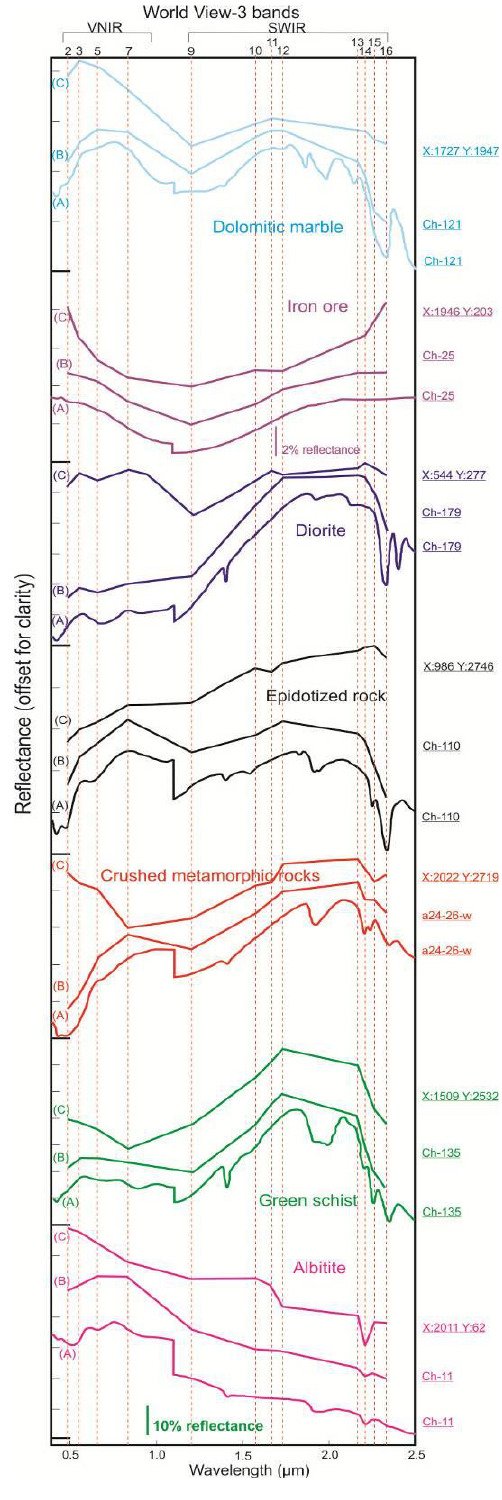
Fig. 8. VNIR-SWIR spectral triplet of (A) high resolution spectra of rock samples from the study area, (B) WV-3 resampled field sample spectra, and (C) WV-3 atmospherically calibrated image spectra from the same study area location of rock units and accompanying alterations. Dotted lines show positions of WV-3 spectral band